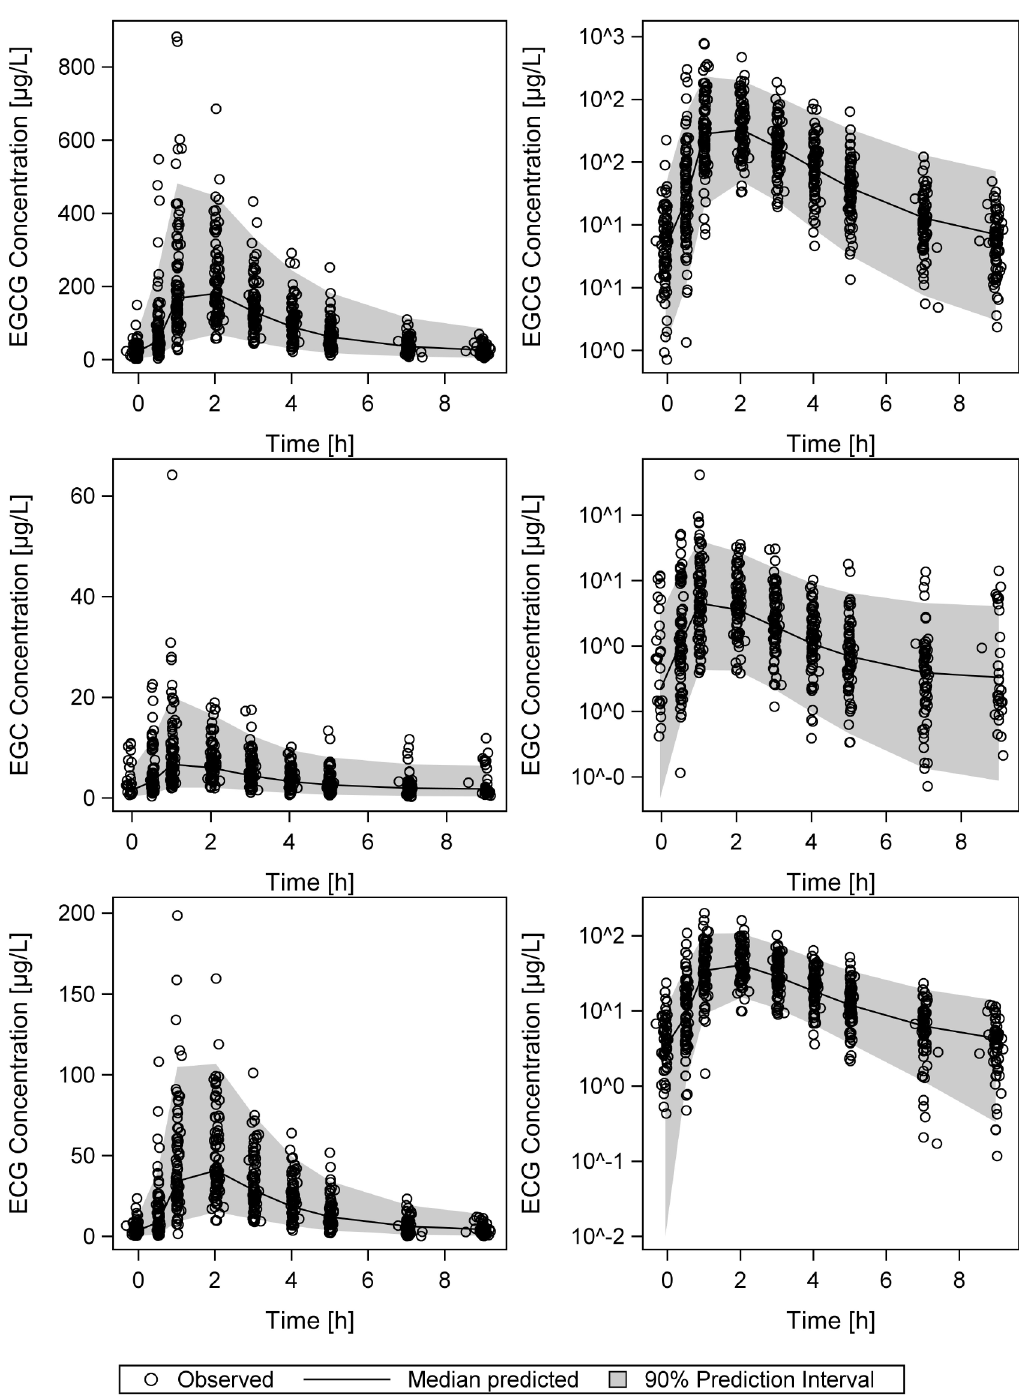
Fig 6. Visual predictive checks of the simulation of 1000 individual plasma concentration-time profiles. Visual predictive checks showing the medians (black lines) and corresponding 90% prediction intervals (shaded grey areas) of the simulation of 1000 individual plasma concentration-time profiles using the final PopPK model parameters of EGCG, EGC and ECG, overlaid with the respective observed data (circles). Linear (left panel) and logarithmic (right panel) presentation of plasma